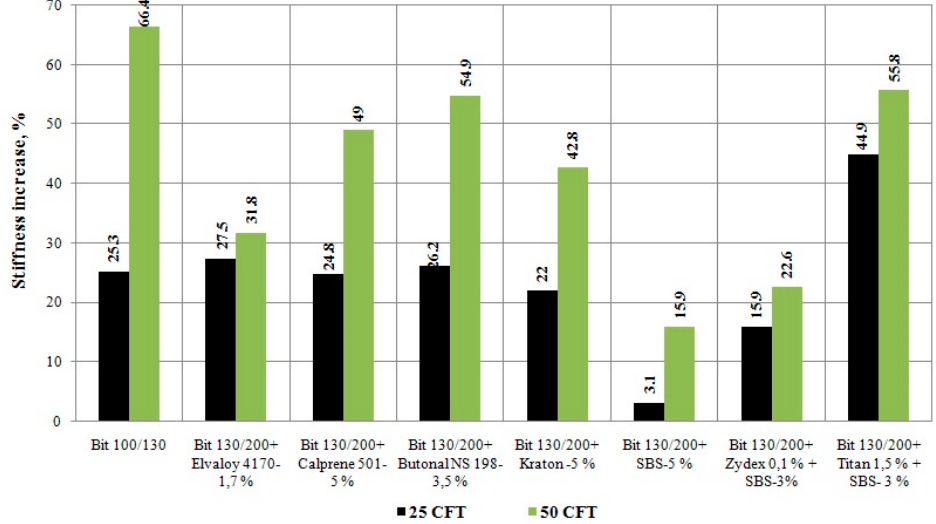
Figure 16. Bitumens stiffness increase after 25 and 50 cycles of FT at the temperature of − 24 ◦ C.